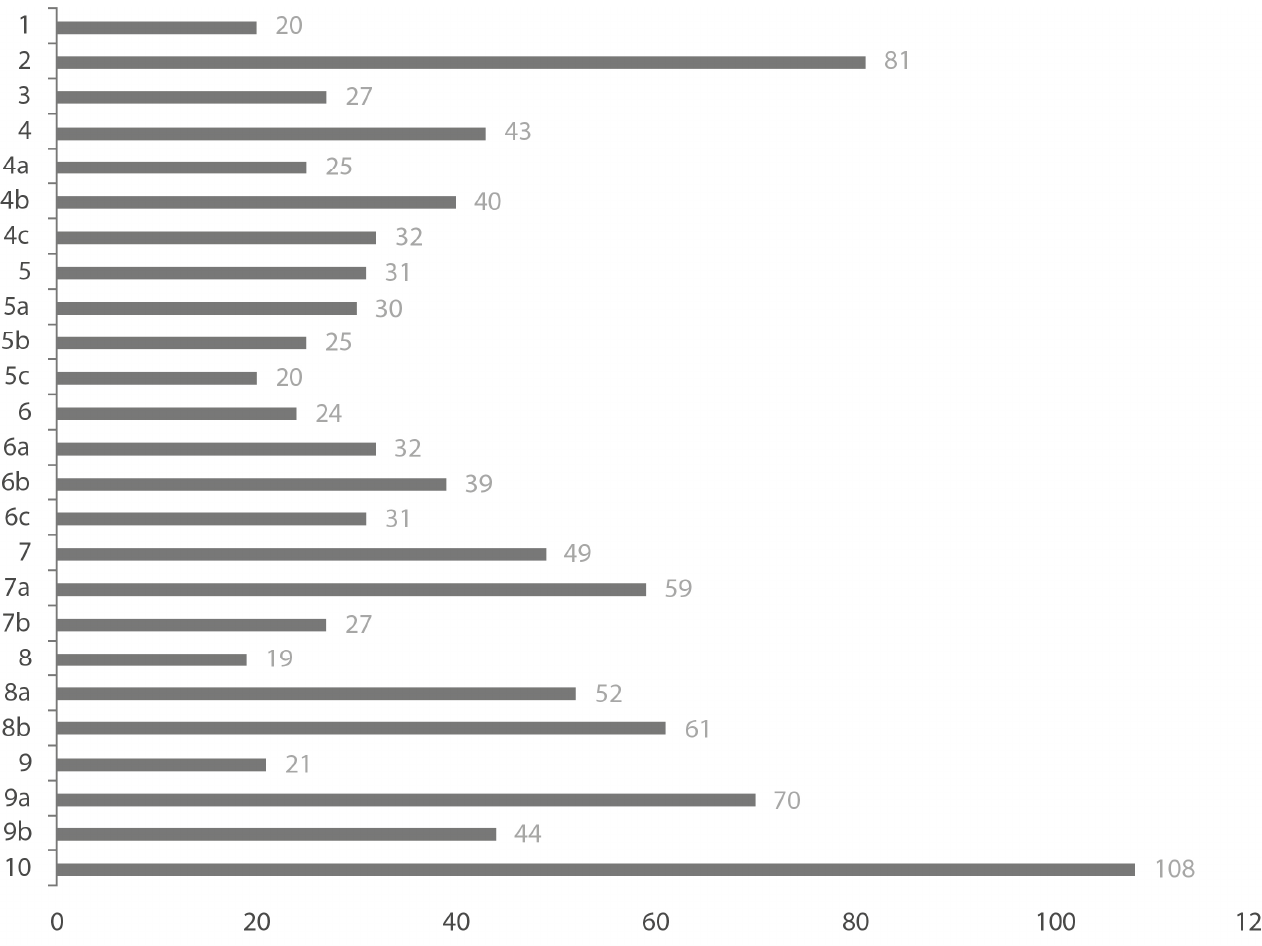
Figure 9. Average task completion time.